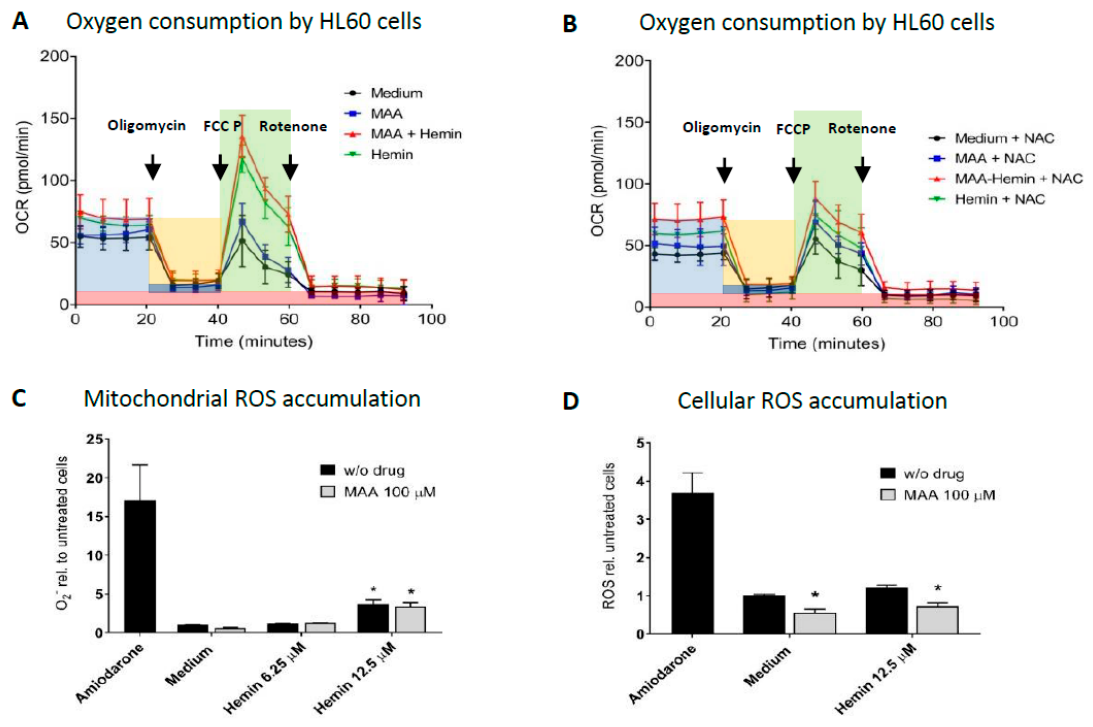
Figure 2. Effect of MAA and/or hemin on cellular oxygen consumption and on mitochondrial and cellular ROS generation. HL60 cells were cultured in the presence of 10 mM glucose and treated with the toxicants for 24 h. ( A ) Effect on cellular oxygen consumption. Oligomycin (1 µM) was added to block mitochondrial ATP production and carbonyl cyanide-4-(trifluoromethoxy)phenylhydrazone (FCCP) (2 µM) to uncouple oxidative phosphorylation. Highlighted in light blue: basal respiration; highlighted in orange: ATP coupled respiration; highlighted in dark blue: proton leak; highlighted in green: maximal respiratory capacity; highlighted in red: non-mitochondrial oxygen consumption; MAA 100 µM, hemin 12.5 µM. ( B ) Effect on cellular oxygen consumption in the presence of the radical scavenger N-acetylcysteine (NAC; 1 mM). ( C ) Effect on mitochondrial superoxide anion generation using MitoSOX. Amiodarone (50 µM) was used as a positive control. ( D ) Effect on cellular ROS production assessed using DHR-123. Amiodarone (50 µM) was used as a positive control. Results are presented related to vehicle-treated control incubations. n = 3 independent experiments in triplicate presented as the mean ± SEM. * p < 0.05 vs. vehicle-treated control incubations.